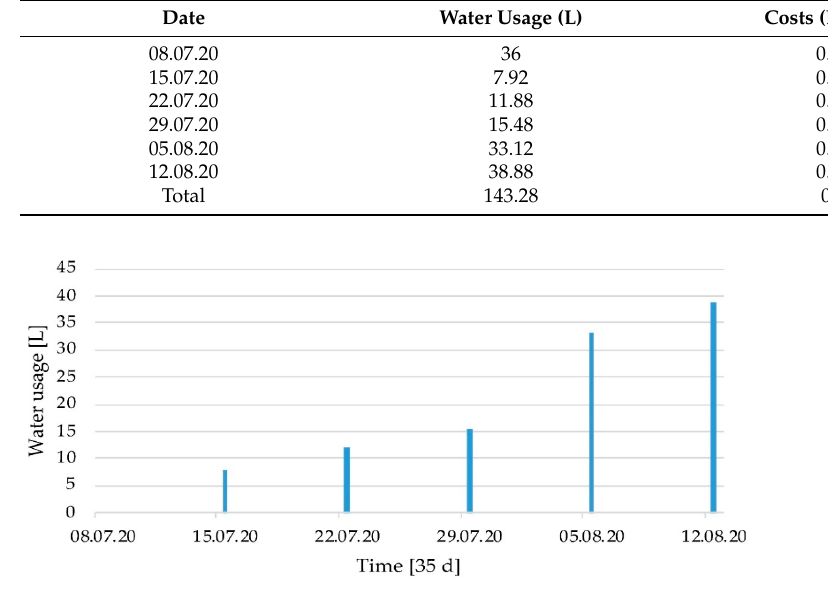
Figure 7. SOF inputs: weekly cumulated water consumption over 35 days. Table 6. SOF inputs: application dates, amounts and costs of irrigation.